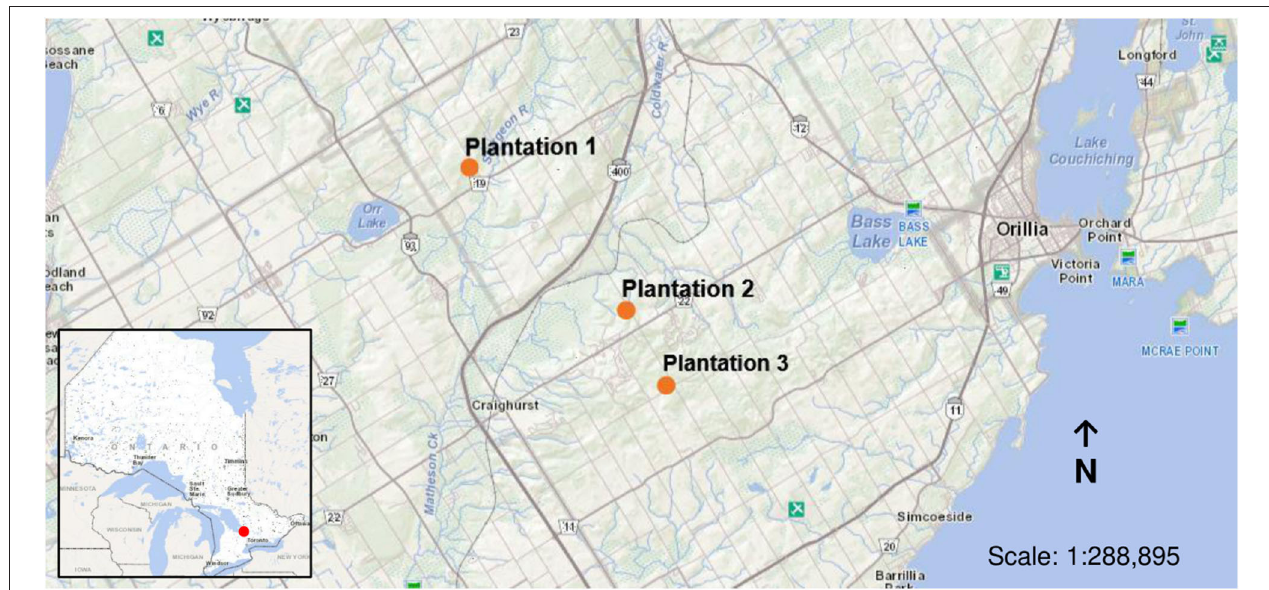
FIGURE 1 | Location of sample sites for the deployment of soil temperature data loggers and inoculated wooden blocks (indicated in orange) within red pine ( Pinus resinosa ) plantations located in Simcoe County,